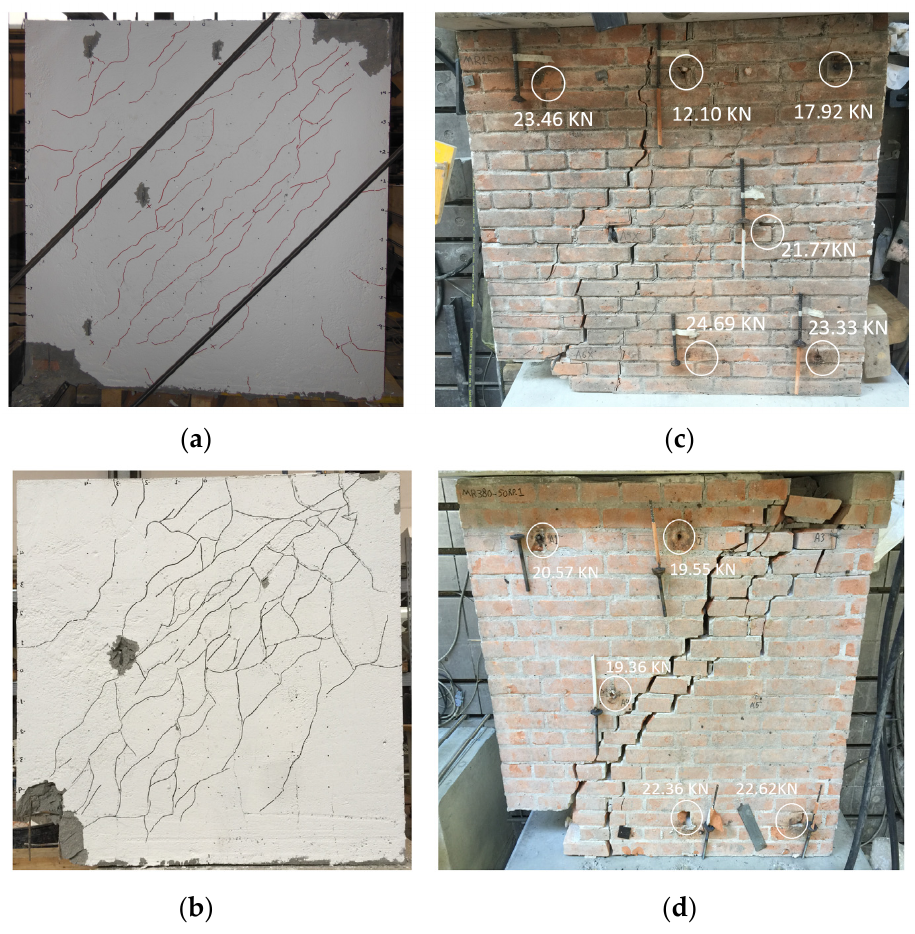
Figure 8. Damaged walls: after wall testing (( a ) wall W2 and ( b ) wall W5) and after anchor testing (( c ) wall W2 and ( d ) wall W5) with residual load.